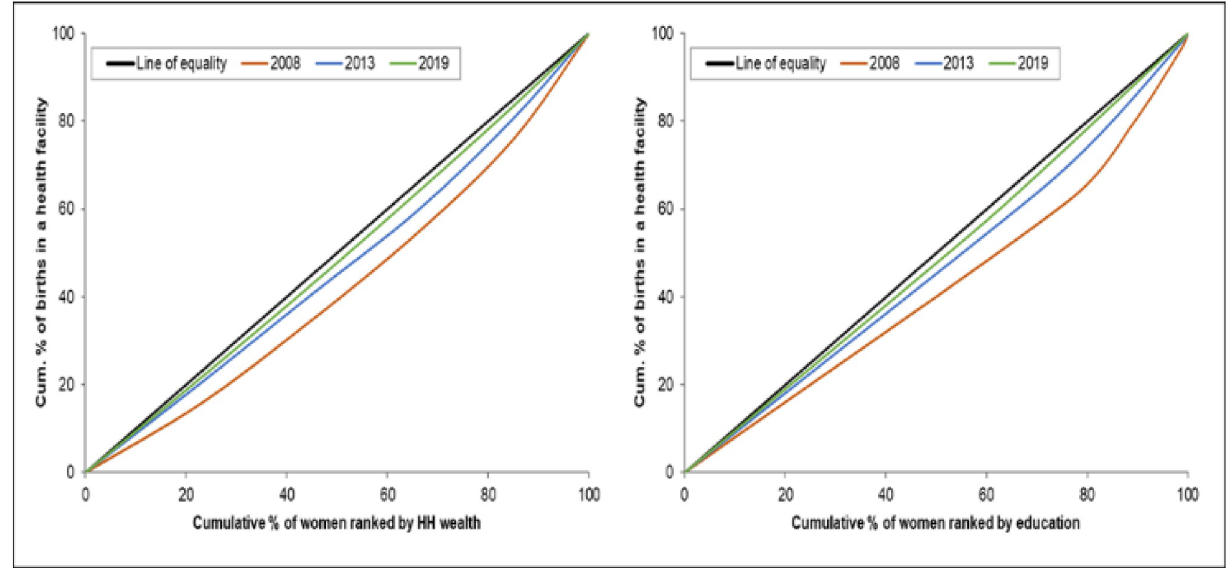
Fig 3. Concentration curves showing wealth-and-education-based inequality in the use of health facilities for delivery in Sierra Leone, 2008, 2013 and 2019.